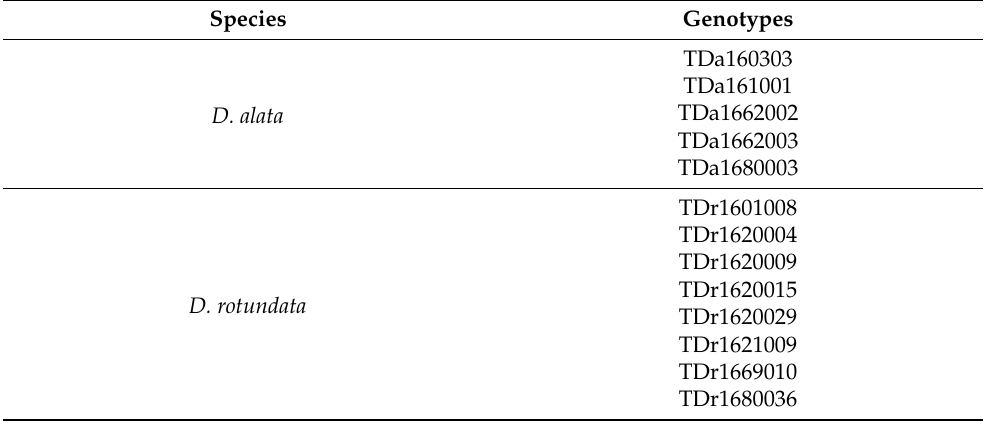
Table 5. Female genotypes used for in vivo fertilization